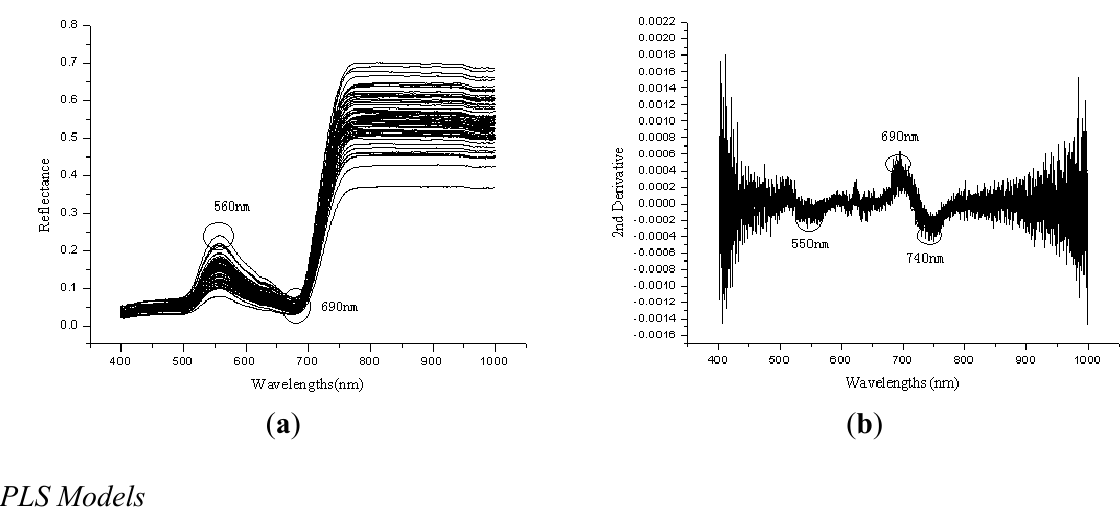
Figure 1. ( a ) The reflectance spectra of all 90 leaf samples in the Vis/NIR region. ( b ) The Vis/NIR spectral curves of leaf samples after 2nd derivative